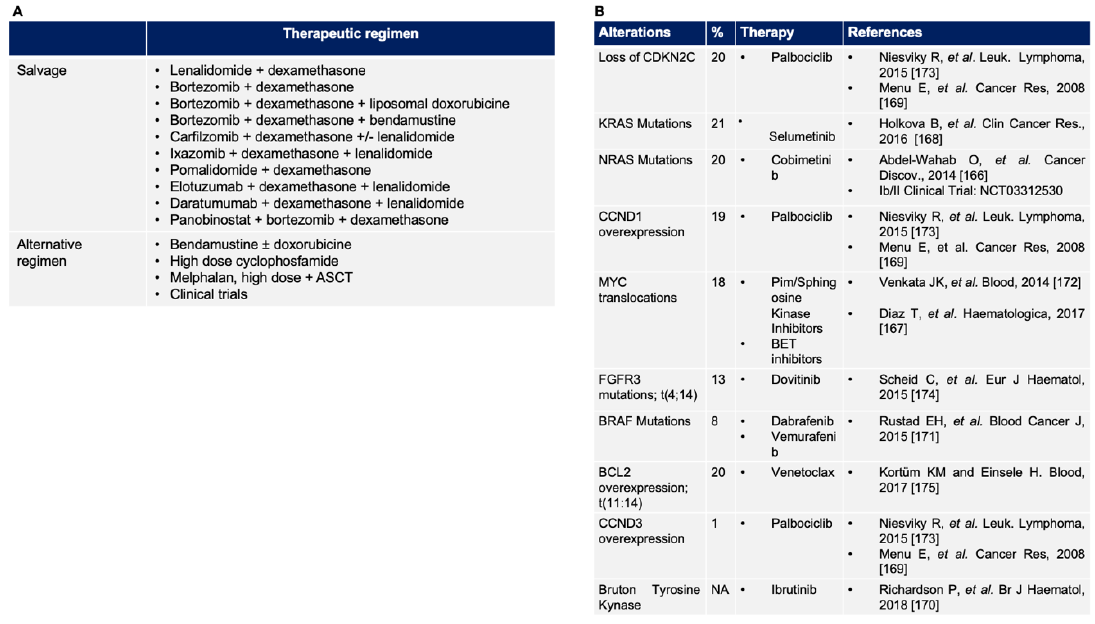
Figure 4. ( A ) Therapeutic regimens for relapse/refractory MM; ( B ) common druggable molecular alterations in MM (see the text and [166 – 175] for details). ASCT, autologous stem cell transplantation.